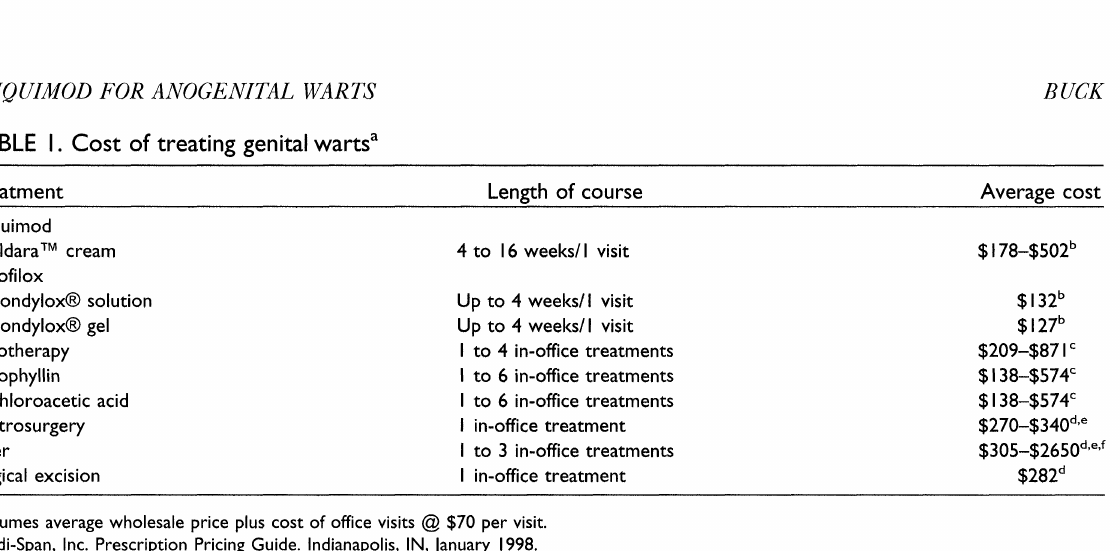
TABLE I. Cost of treating genital warts Treatment Length of course